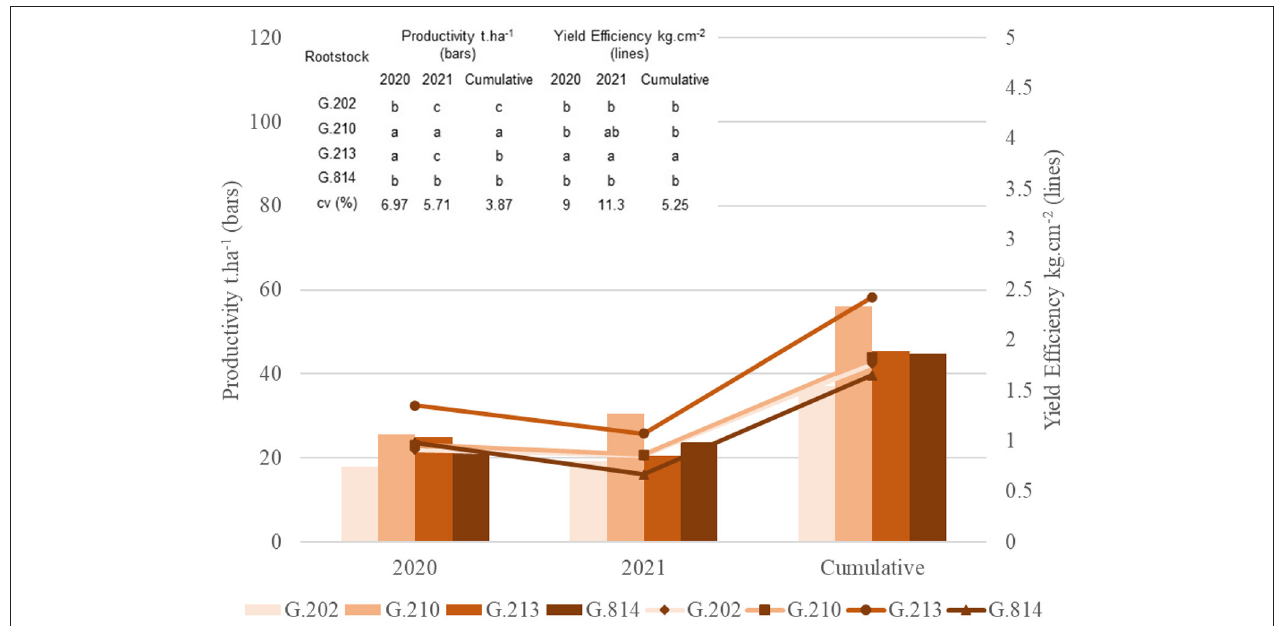
FIGURE 7 | Yield and yield efficiency of the Gala Select cultivar grafted on different rootstocks, under replanting area in Vacaria. Yield and yield efficiency that do not share a letter are significantly different (Tukey’s test, α = 0.05).